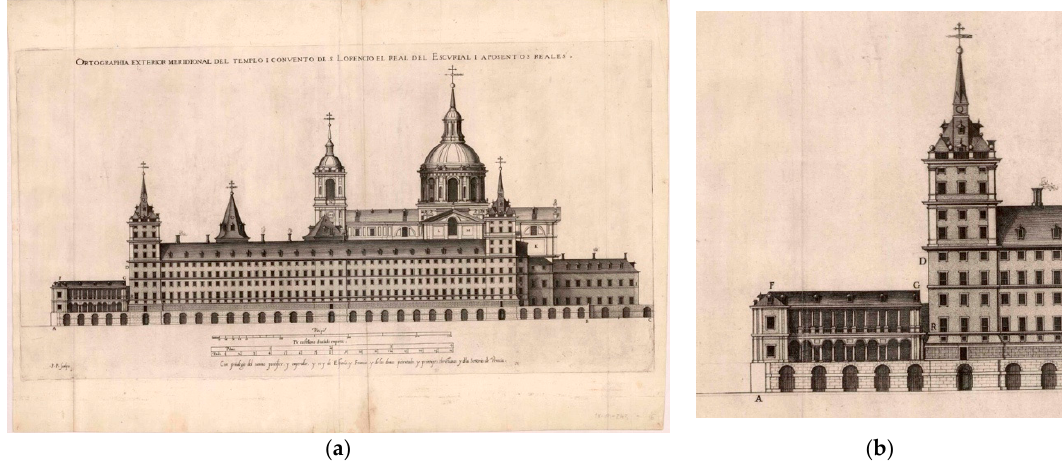
Figure 6. Juan de Herrera and Pedro Perret, 1587: Sexto diseño. Ortographia exterior meridional del Templo i Convento de S. Lorencio el Real del Escurial i Aposentos Reales. ( a ) South elevation. ( b ) Detail of the Galería de Convalecientes or Corredorcillos del Sol, that are located on the left side of the drawing. Real Biblioteca, Palacio Real de Madrid, Bookmark IX-M-243(6). Detail of Figure 6b depicts the Galería lettered ‘F’ and ‘G’ over the ridge. Letter ‘R’ refers to the position of the exterior walkway that links the Torre de la Botica (Tower of the Apothecary or Southwest Tower in the Monastery) to the first floor of the Galería .